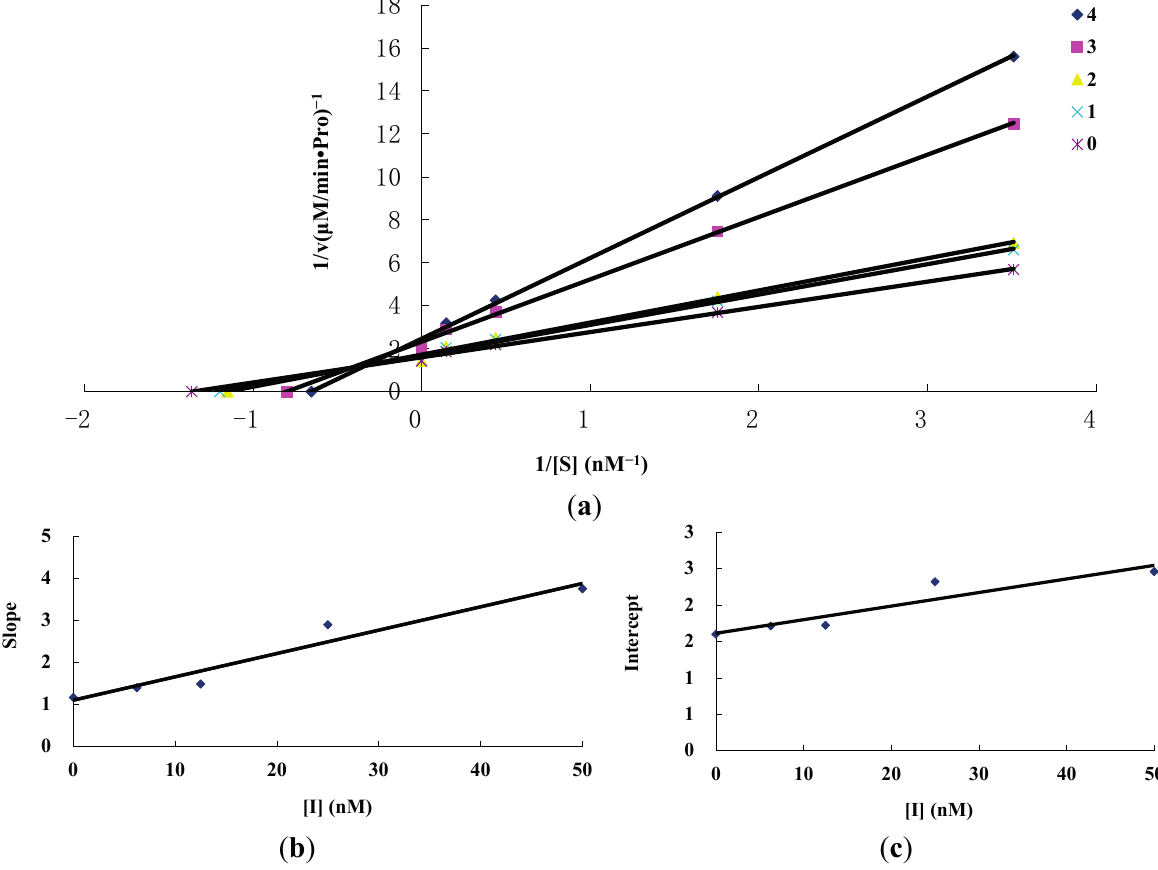
Figure 3. Inhibition kinetics of amorphigenin on mitochondrial complex I by Lineweaver–Burk plots. ( a ) Concentrations for curves 0–4 were 0, 6.25, 12.5, 25 and 50 nM, respectively; and ( b , c ) represent the secondary plots of the slope an d intercept of straight line versus concentration of inhibitor,